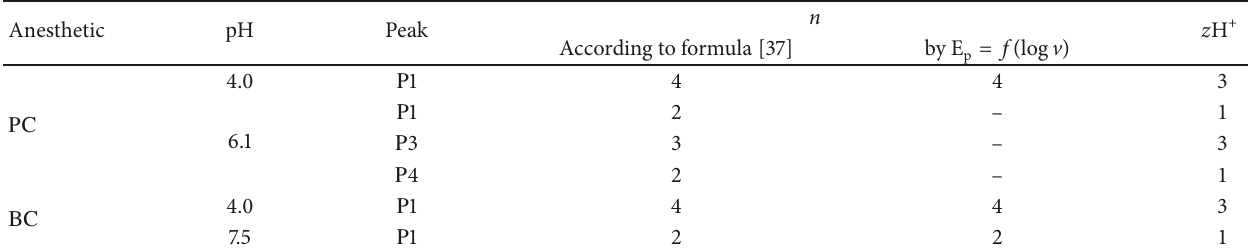
Table 3: The calculated number of electrons ( n ) and ions of H + ( z H + ) involved in electrochemical reduction of BC and PC derivatives at